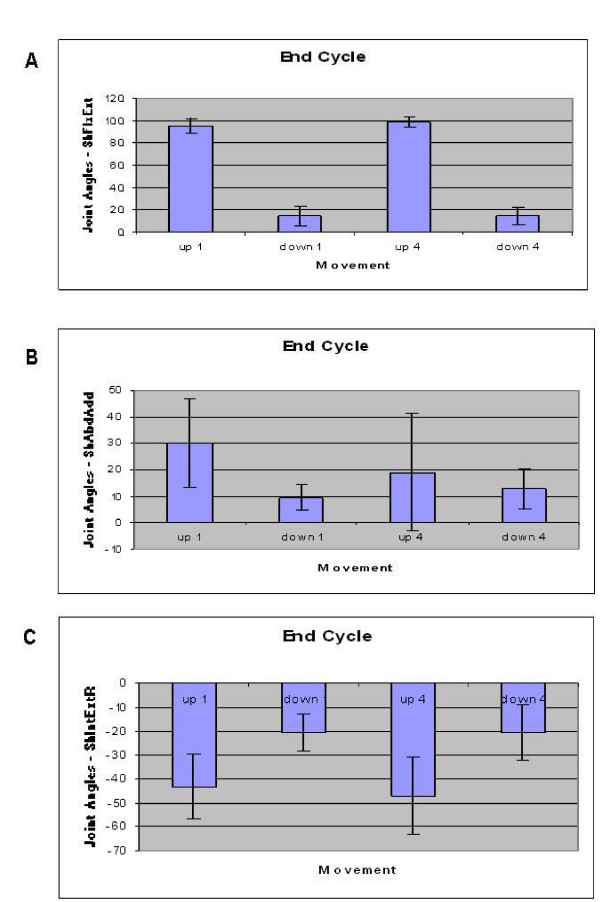
Shoulder ROM during repetitive high height task. Values acquired from development studies. A – Shoulder Flexion/Extension; B – Shoulder Abduction/Adduction; C – Shoulder Internal/External Rotation.